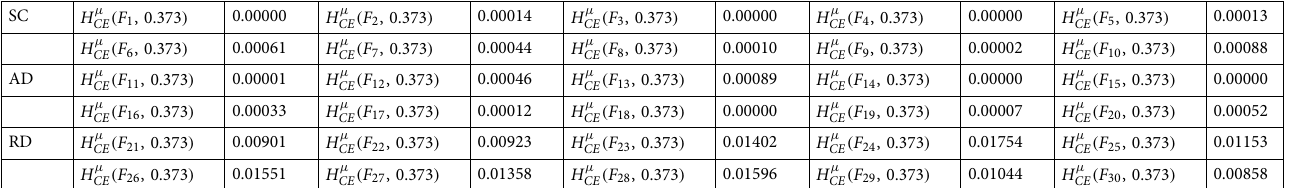
Table 8. Computation of FCE measure values between the fuzzy sets of various fault types in high frequency